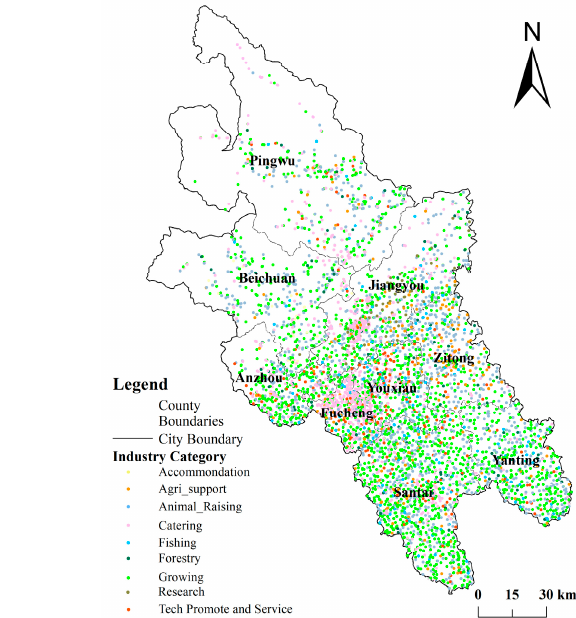
Figure 7. Median center of industry type of rural entrepreneurship in Mianyang in 2011, 2015 and 2020. 4.2. Dynamics of Rural Entrepreneurship Context in Mianyang Based on the measurement factors identified in previous rural entrepreneurship re- search (Table 1), this study developed a conceptual framework (Figure 8) with determi- nants (Table 2) to guide our determinants detection. Physical conditions are represented by natural resources endowment which consists of annual average temperature (Tair.) and precipitation (Prec.) in each different sub-administration of Mianyang. To capture the